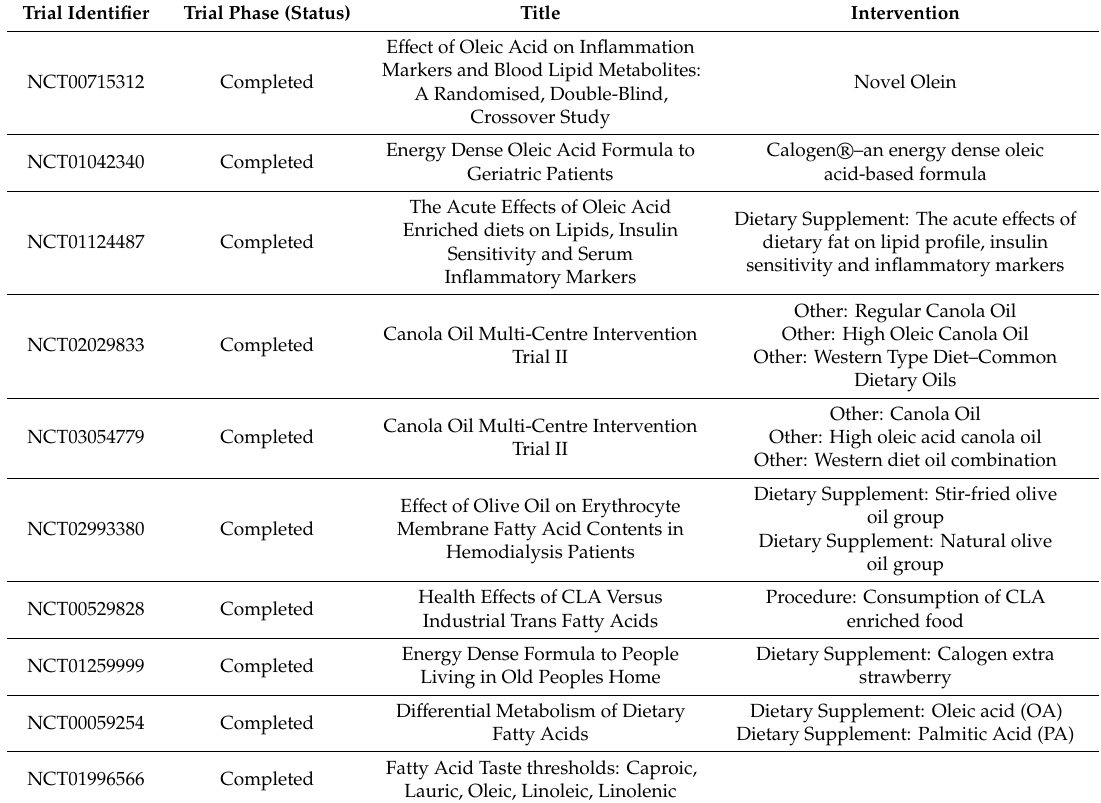
Table 2. Oleic acid clinical